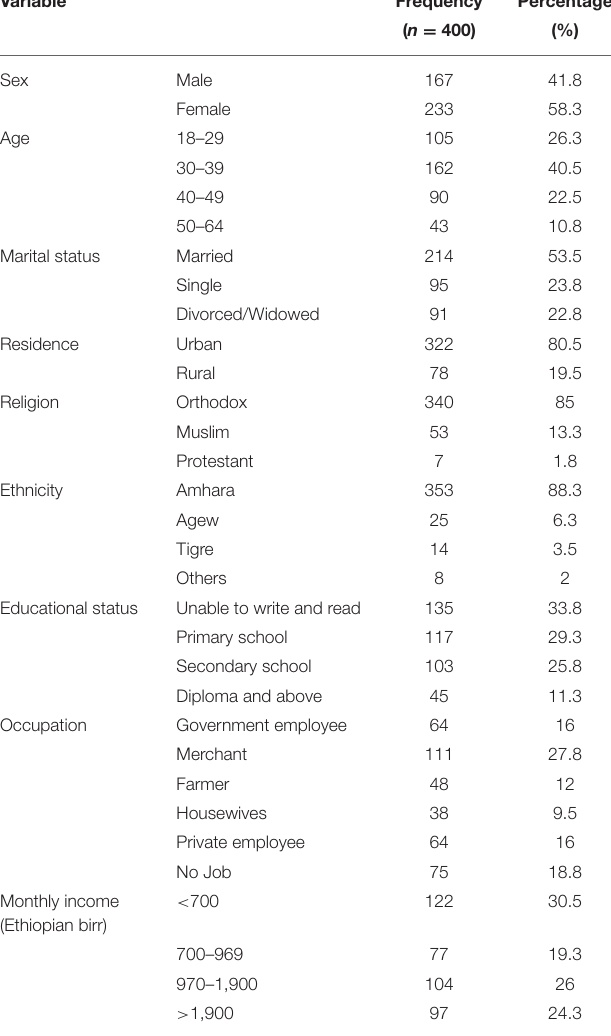
TABLE 2 | Distribution of PLH by their clinical status at government health institution in Bahir Dar, Ethiopia, 2016. Variable Frequency Percent